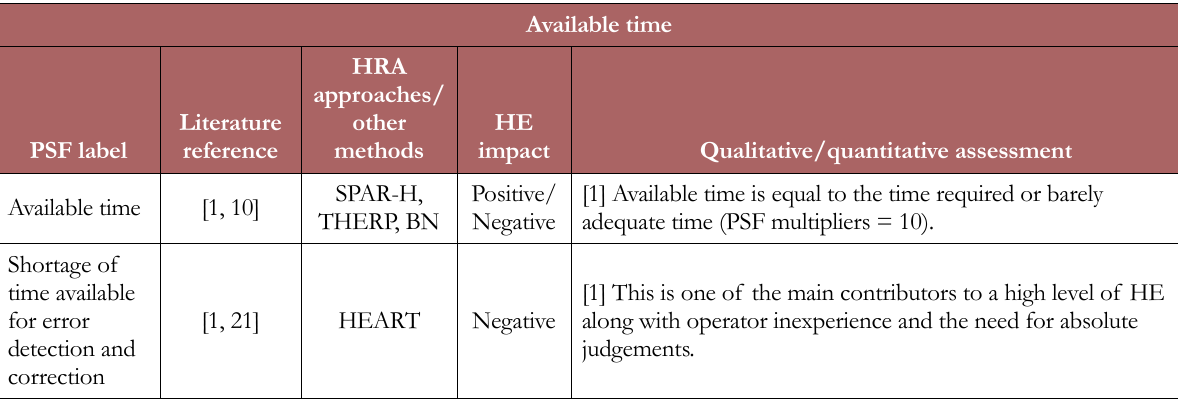
Table 10. Taxonomy of maintenance PSFs: available time factor